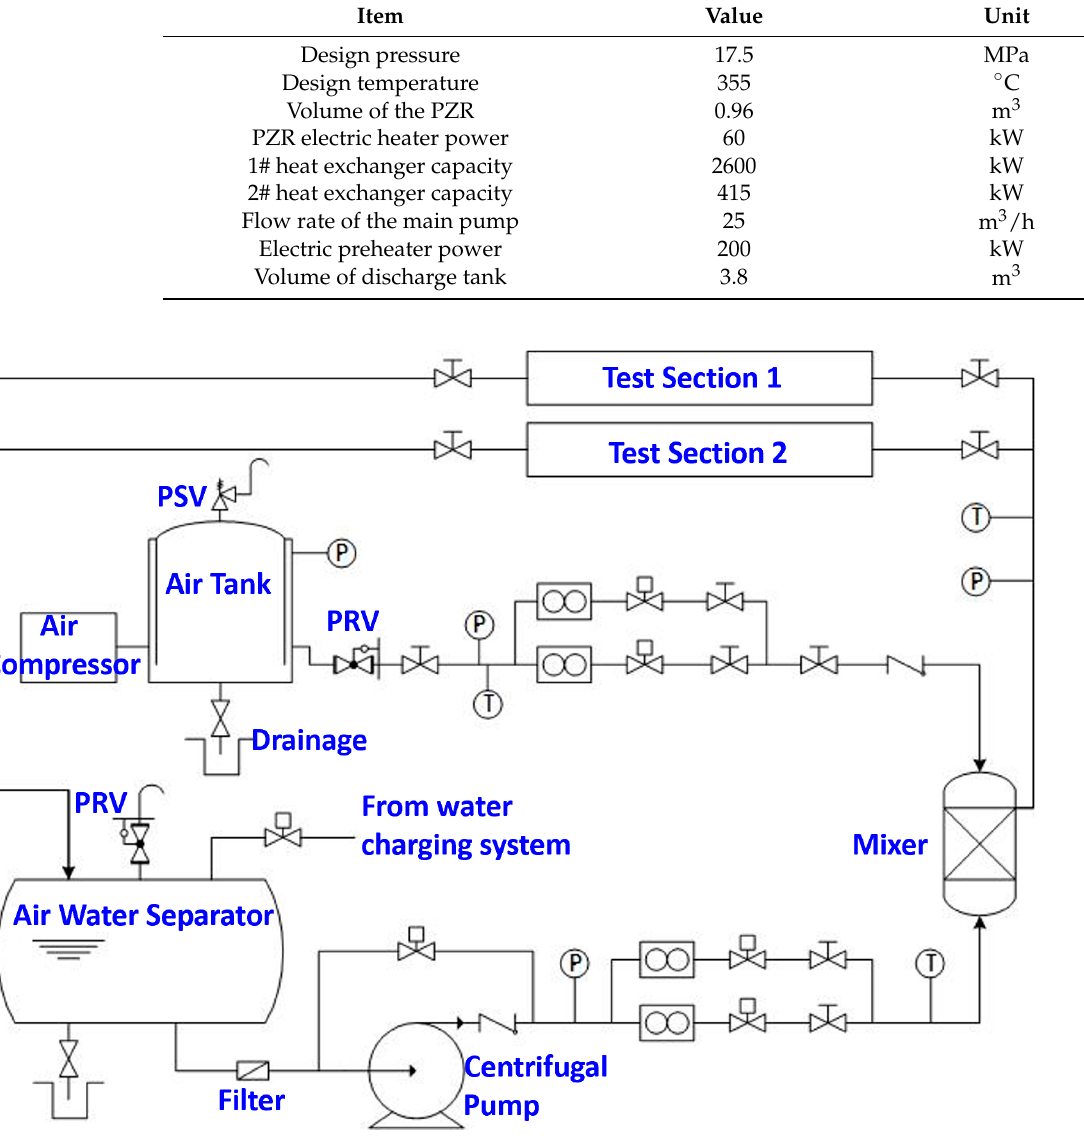
Table 4. Design parameters of the low pressure water loop.